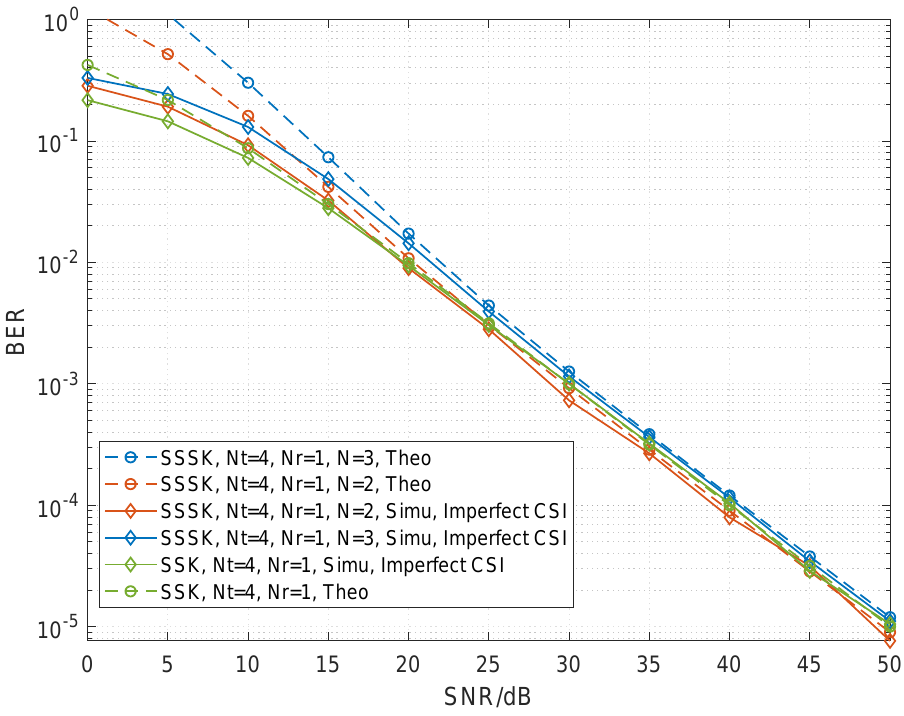
Figure 3. Performance comparisons between the sparse SSK for different values of N and conventional SSK having N t = 4 and N r = 1 at 2 bits/s/Hz with Gaussian estimation error.